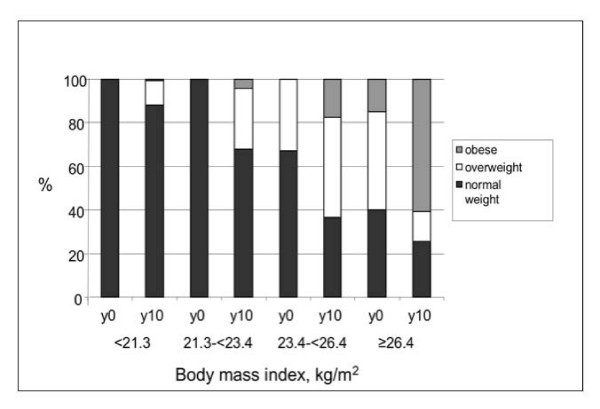
Presence of overweight and obesity according to NHLBI cutpoints (overweight body mass index (BMI) 25–29.9 kg/m2, obese BMI ≥ 30 kg/m2), by quartile of baseline BMI; and progression over 10 years.